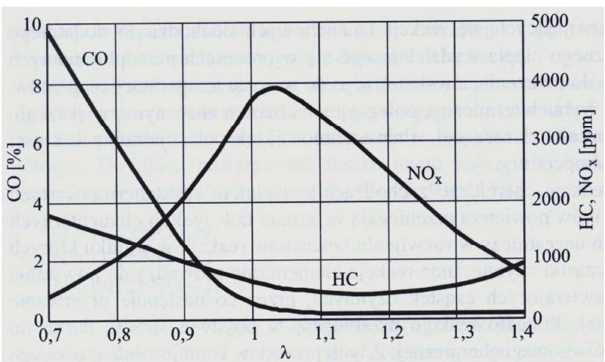
Fig. 1. Carbon monoxide CO, hydrocarbons HC and nitrogen oxides NO x concentration values depending on the air-fuel ratio [3]